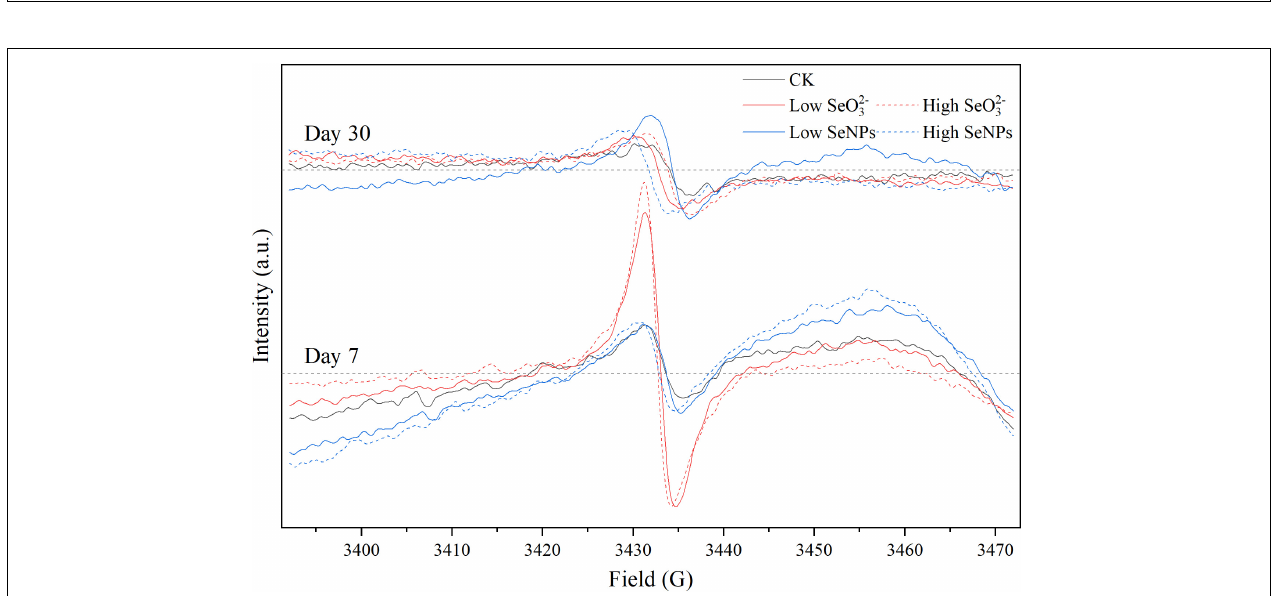
FIGURE 5 | Electron paramagnetic resonance (EPR) spectra of each experimental group on Days 7 and 30.